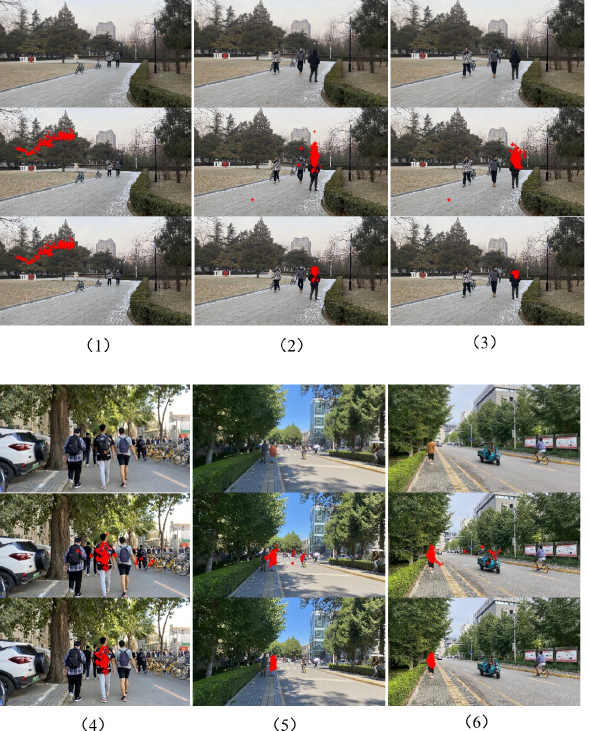
Figure 16. Comparison of gaze points during the real scene images. (1)–(6) is the number of the images, these number where be used in Table 6.